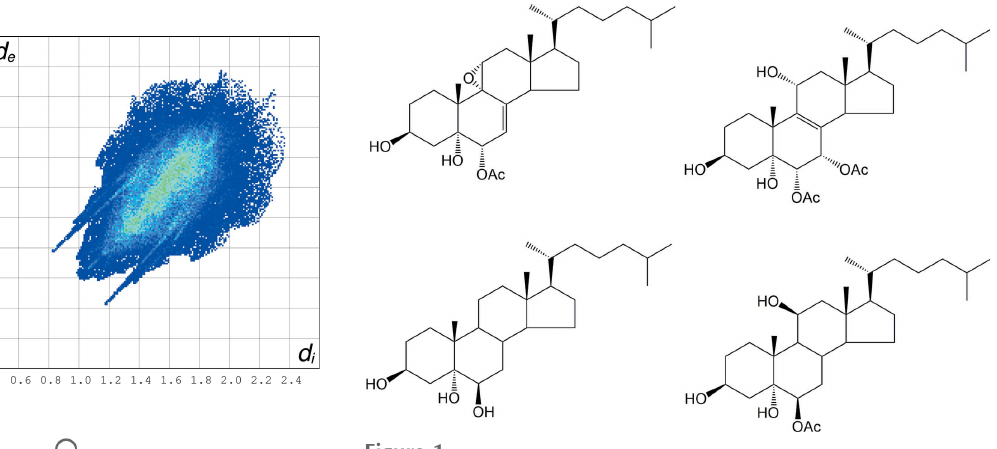
Figure 1 Selected biologically active polyoxygenated steroids of marine